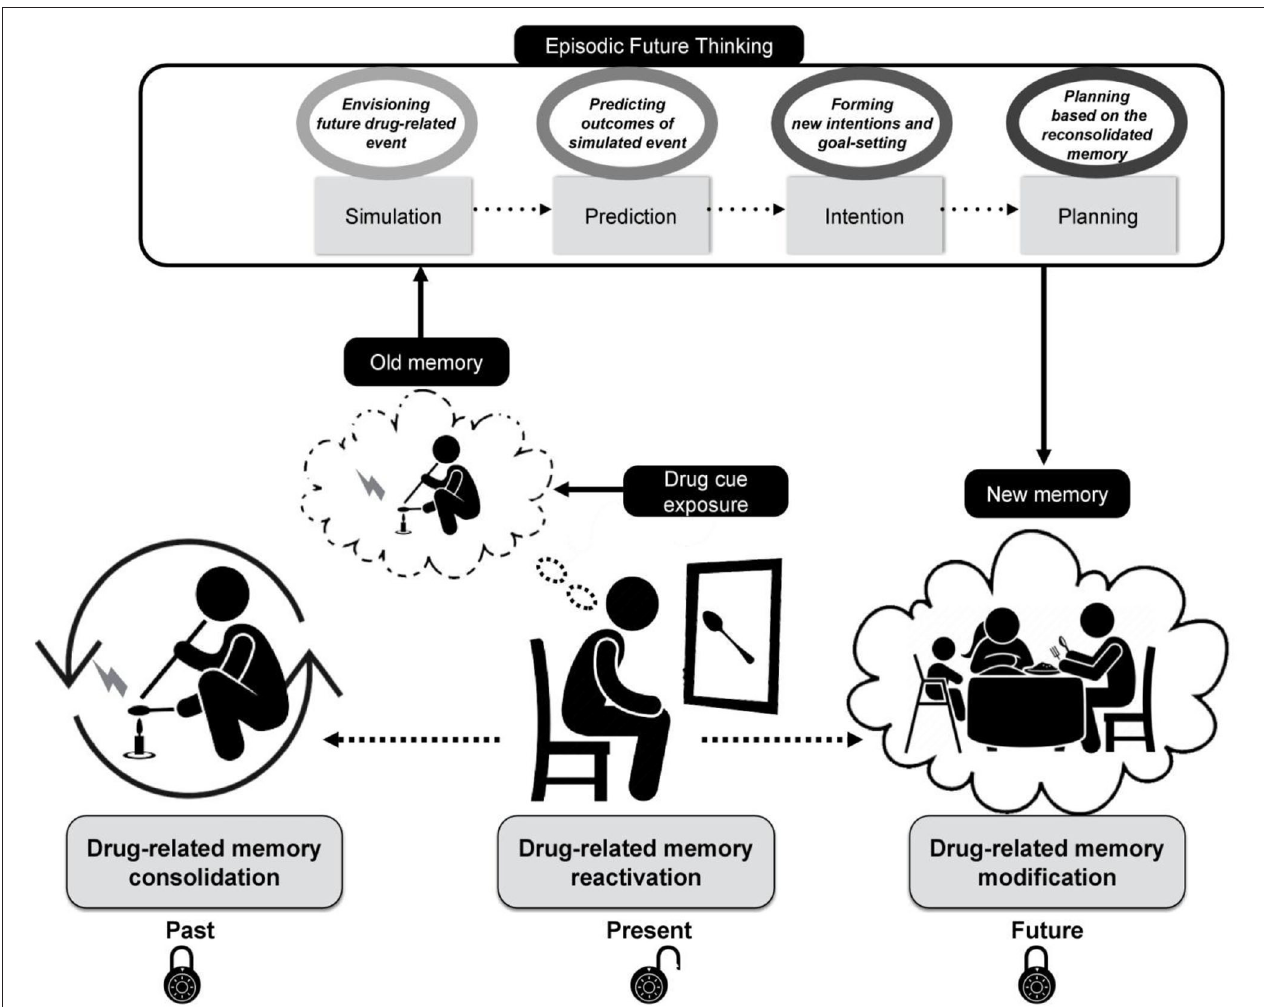
FIGURE 1 | A schematic diagram illustrating the cognitive processes underlying “Cue-induced Retrieval and Reconsolidation with Episodic Foresight (CIREF),” which applies episodic future thinking to cue-induced memory reconsolidation. The maladaptive drug-related memory that has been consolidated and stored in the past (Left) becomes reactivated as a result of drug cue exposure (Middle). The reactivated memory becomes transiently labile and prone to modification. The extinction process of maladaptive drug-related memories takes place as a result of repetitive exposure to relevant drug cues. Implementing episodic future thinking during this stage engages the person in (1) simulation of a future drug-related event, (2) prediction of emotions and reactions related to it, (3) intention of modifying the drug-seeking behavior triggered by cue exposure, and (4) planning for future actions in response to drug cue exposure maintaining healthy behavior (Top). The boxes in oval shapes depict processes underlying each stage. The reconsolidated memory is therefore updated and re-encoded in aid of episodic future thinking, and the drug cue has undergone extinction as a result of cue exposure therapy (Right).